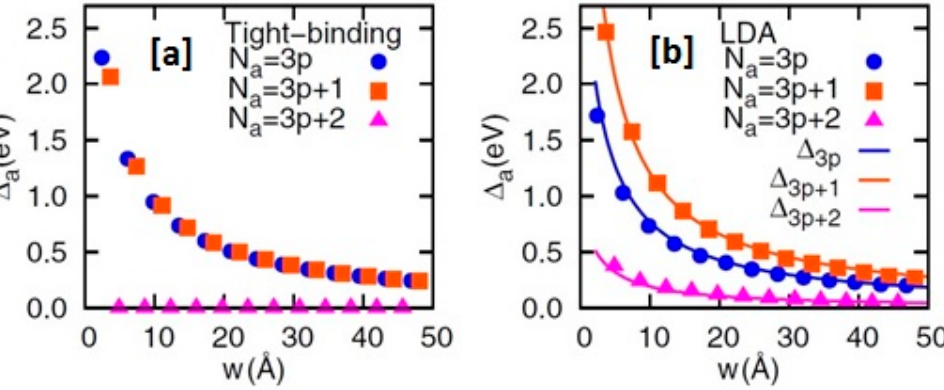
Figure 4. Variation of the band gap of armchair graphene nanoribbons (GNRs) as a function of the width ( w ) obtained ( a ) from tight binding (TB) calculations with t = 2.70 eV (nearest neighbor hoping integral) and ( b ) from first-principles calculations within the local-density approximation (LDA) [39]. The number of dimer N is represented as N a in this figure. Reproduced with permission from [39]. The American Physical Society, 2006.